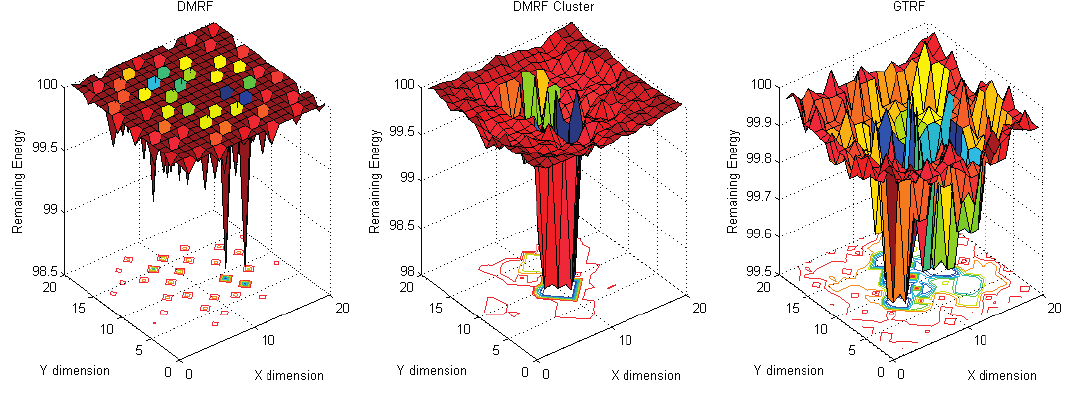
Figure 7. Energy cost with fixed sink with random source without selfish